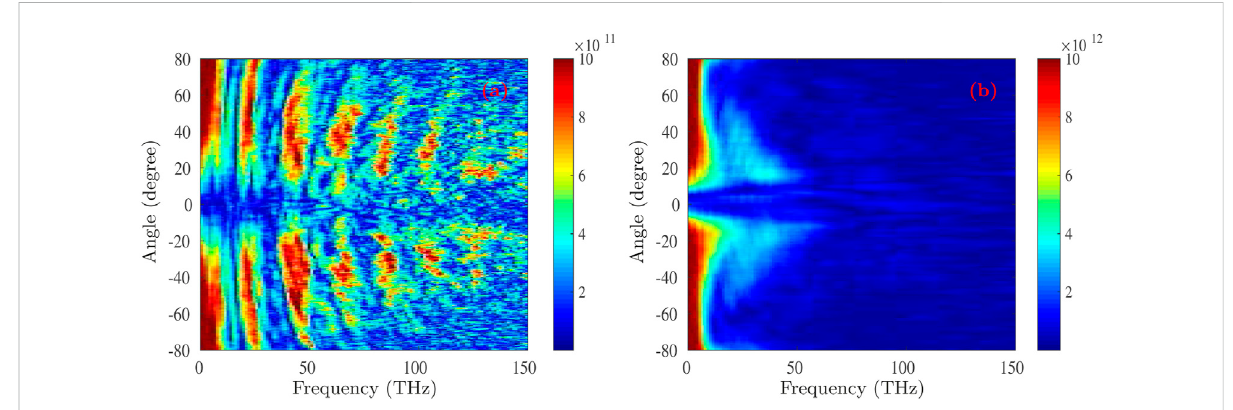
FIGURE 3 The angular-spectra distribution of the THz radiation for both of the fl at target (A) and TTT (B) .